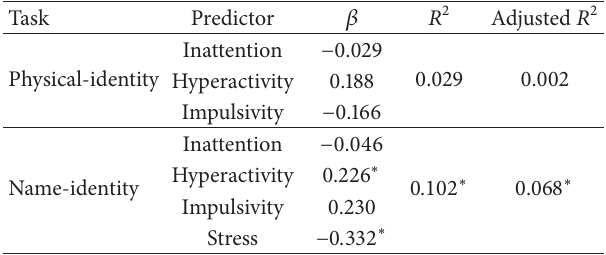
Table 4: The final models of multivariable regression analyses predicting interhemispheric interaction index in each task from inattention, hyperactivity, and impulsivity subscales of the CAARS and the backward selection of the DASS